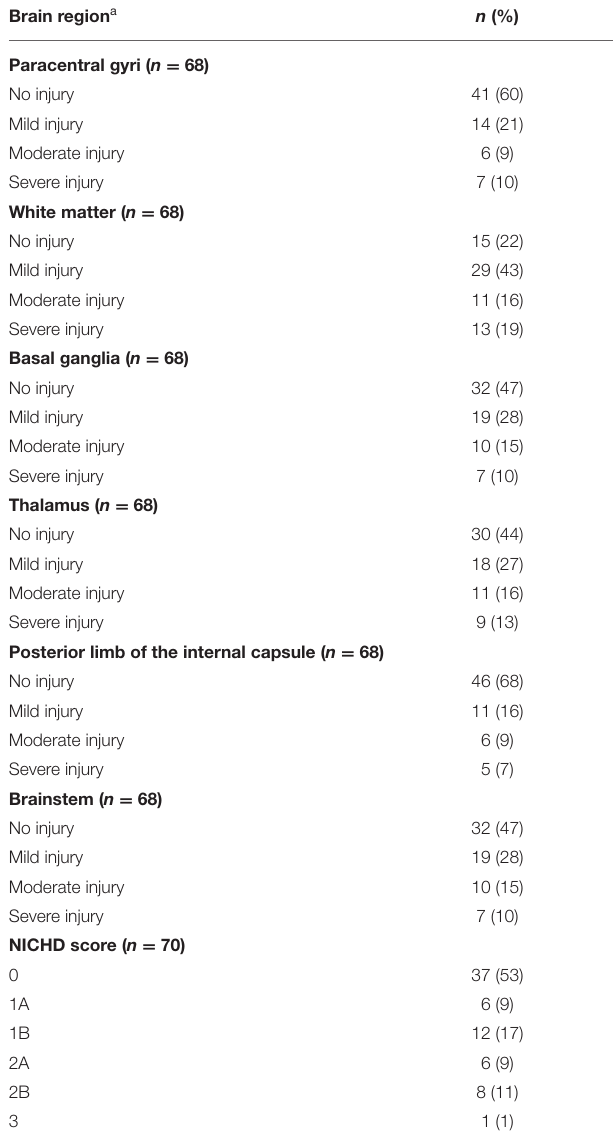
and Human Development score. Brain region